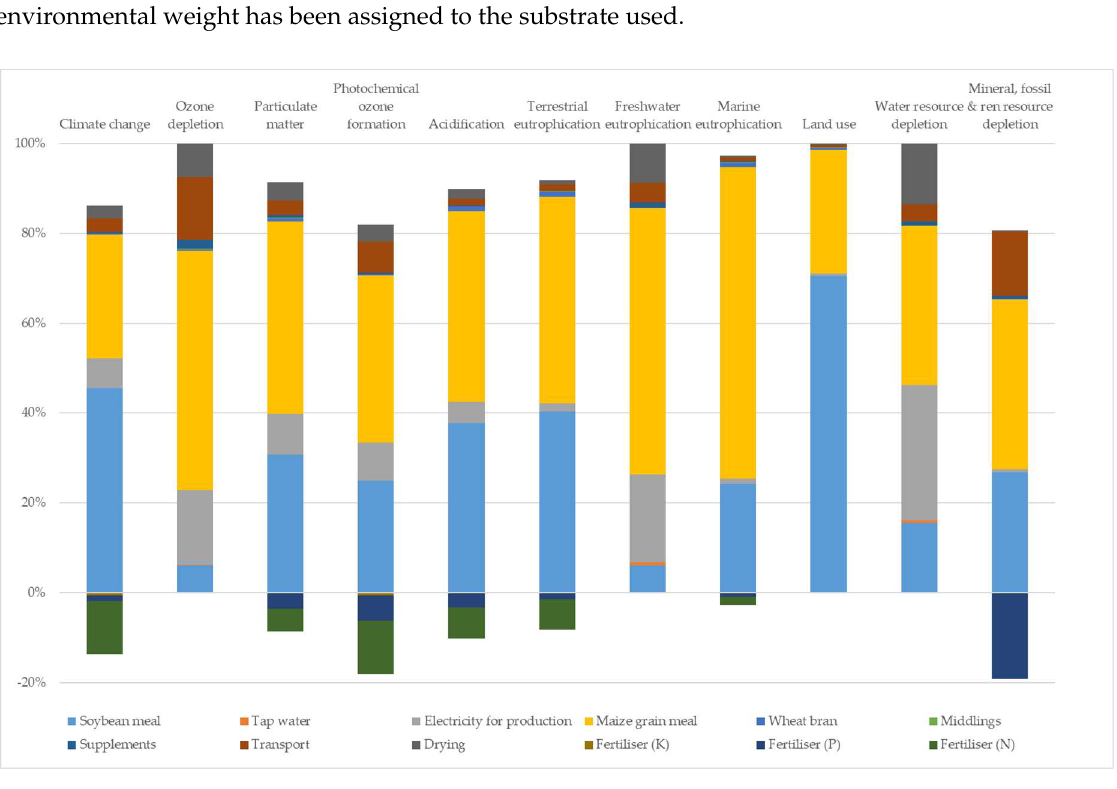
Figure 3. Relative weight of different processes of larvae grown on maize distiller.